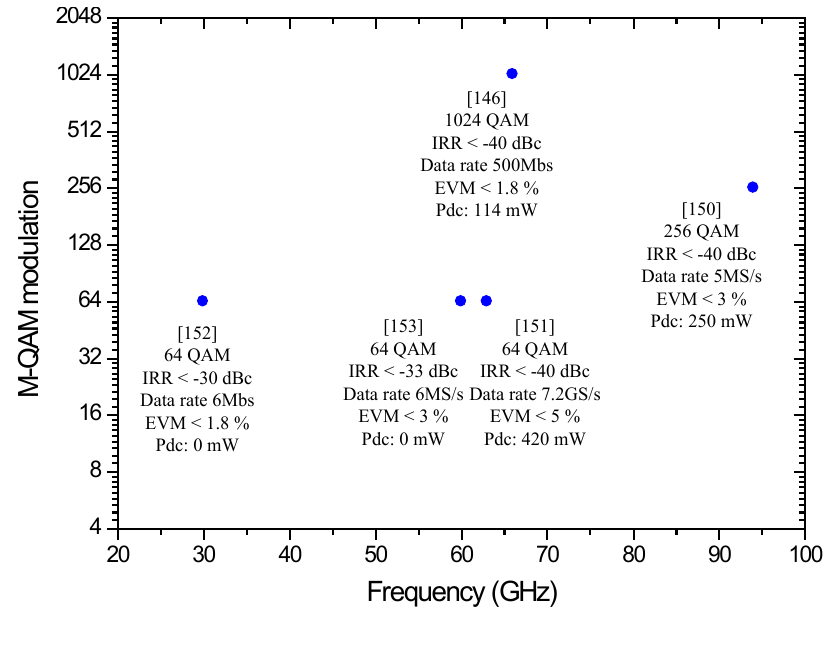
Figure 13. Comparison of the MMW high-order quadrature amplitude modulation QAM modulation. Data taken from